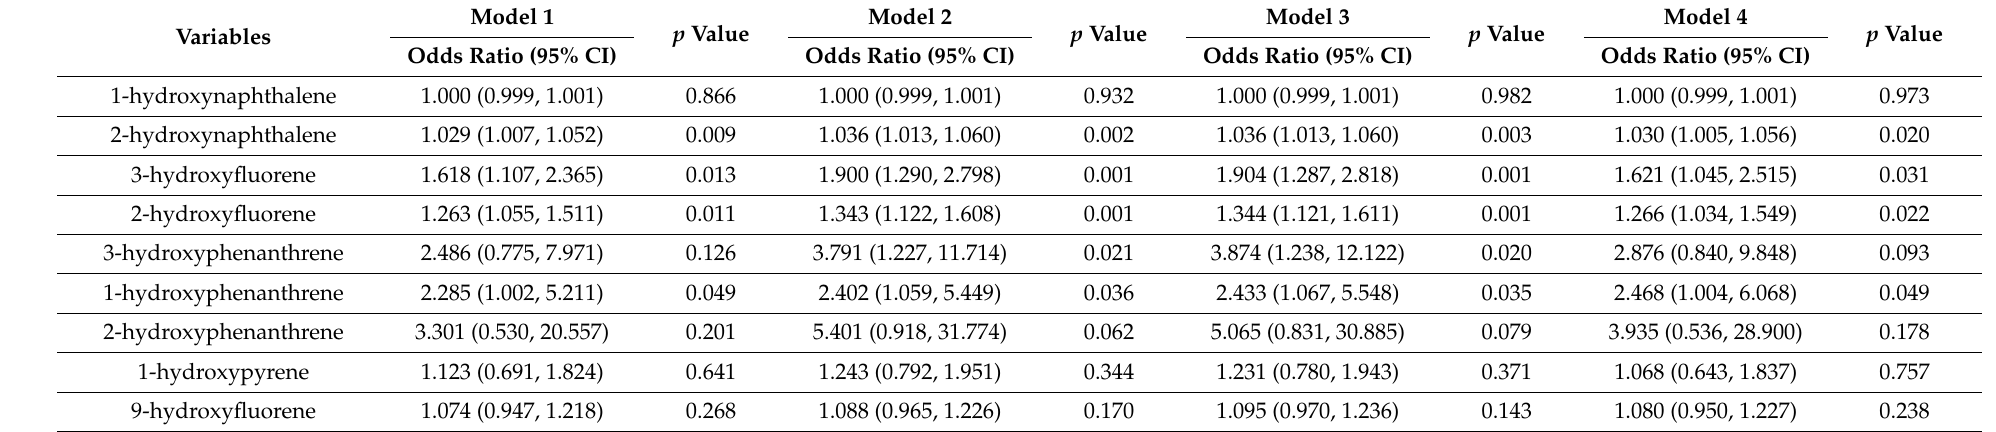
Table 3. Association between PAHs and diarrhea.